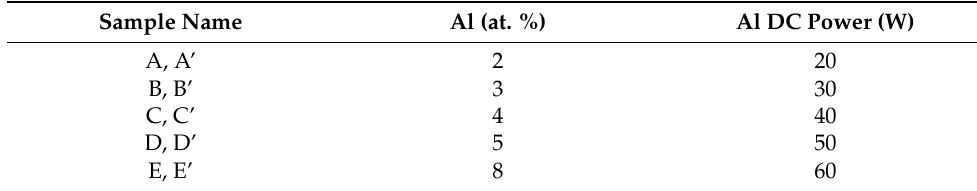
Figure 2. ( a ) Core of the homemade setup used for the measurement of the Seebeck coe ffi cient, con- sisting of two Peltier devices used for heating and cooling the edges of the samples deposited on glass slides. ( b ) Vacuum chamber, containing the Seebeck measurement setup.